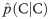
Distributions of each cooperation probability calculated separately for the partner’s previous decision.(A) Direct reciprocity game. (B) Generalized reciprocity game. Boxplots indicate the participant’s empirical cooperation probabilities: p(C|C) and p(C|D). The point on each boxplot, the box, the thick line in each box, and the whisker represent each participant, the interquartile range (IQR), the median, and the distances 1.5 × IQR, respectively. The open triangles represent the overall fraction of cooperation averaged over all participants (the error bars represent 95% confidence intervals: ±1.96 × standard error). The filled circles and bars adjacent to the right-hand side of each boxplot indicate the predicted distributions of group-level cooperation probabilities inferred from the partner’s action (PA) model, p^(C|C) and p^(C|D). Each filled circle and bar represent the median and the 95% compatibility interval of the predicted distribution, respectively. Each label on the horizontal axis indicates the partner’s decision in the previous round: C, the partner cooperated; and D, he/she defected.